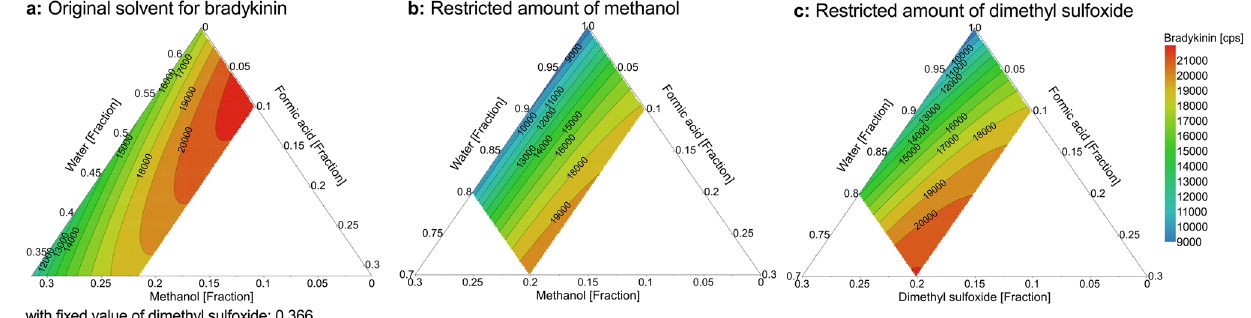
Figure 2. Contour plots of the D-optimal optimization for the response of bradykinin in distinct injection solvent compositions. In comparison to the contour plot including the original injection solvent for bradykinin with a fixed fraction of 0.366 dimethyl sulfoxide ( a ), restriction of the organic amount in context with the comprehensive determination of seven kinin peptides ( b and c ) lead to a shift to highest compatible organic